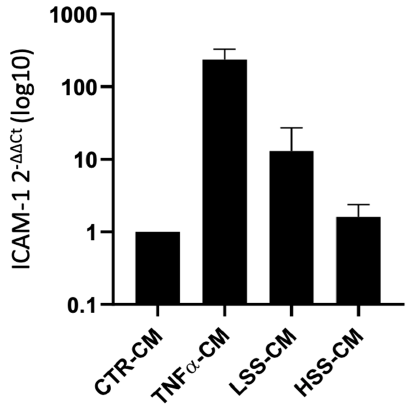
8 of 26 Figure 7. Western blot analysis of HUVEC cell lysates after 24 h of stimulation with TNF α -, LSS- and HSS-conditioned media (-CMs). ( A , B ) show the expression of eNOS and E-selectin, respec- tively, while ( C , D ) represent the normalization data by using tubulin expression level (* p < 0.05 and *** p < 0.005). 2.2.3. ICAM-1 mRNA Expression Is Upregulated by LSS-CM ICAM-1 mRNA expression was evaluated through quantitative real-time RT-PCR. The results of the amplification curves were used to build ΔΔ Ct graphs (Figure 8). This